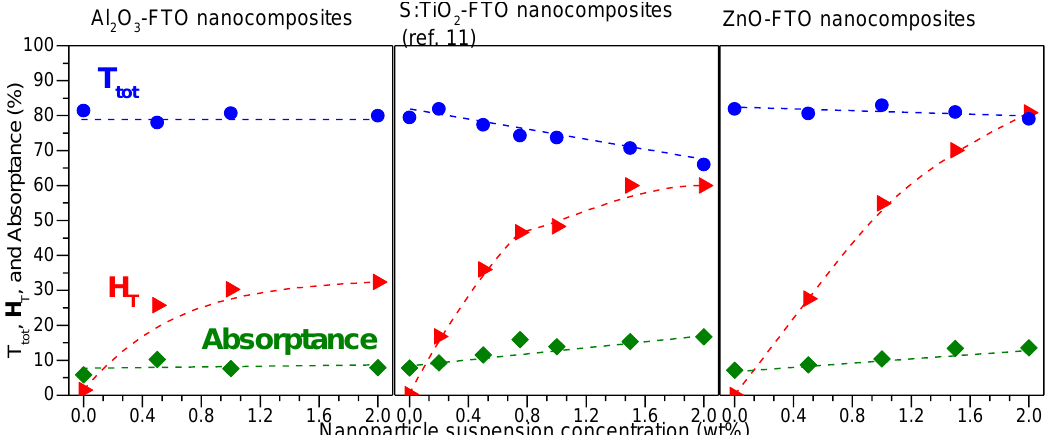
Figure 7. Haze factor (H T ), total transmittance (T tot ), and absorptance at 635 nm for Al 2 O 3 -FTO, S:TiO 2 -FTO (as reported in [11]), and ZnO-FTO nanocomposites plotted as a function of nanoparticle suspension concentration. Dashed lines help to guide the eyes.